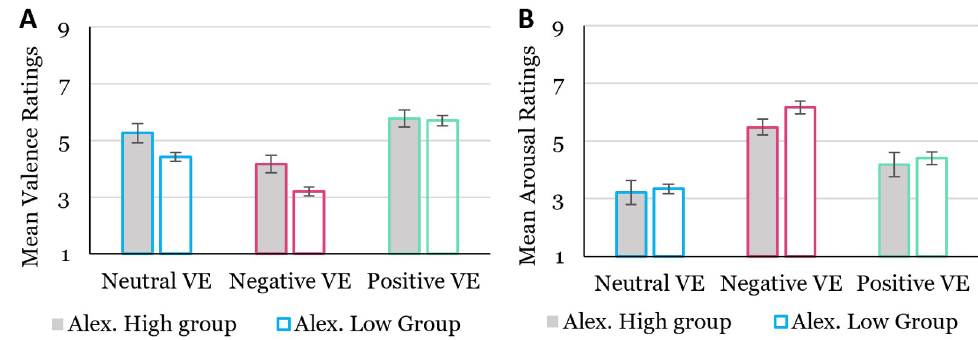
Fig 7. Mean valence and arousal ratings per alexithymia group. Left figure (A): Mean valence ratings across events for each condition. Right figure (B): Mean arousal ratings across events for each condition. (SE error bars).